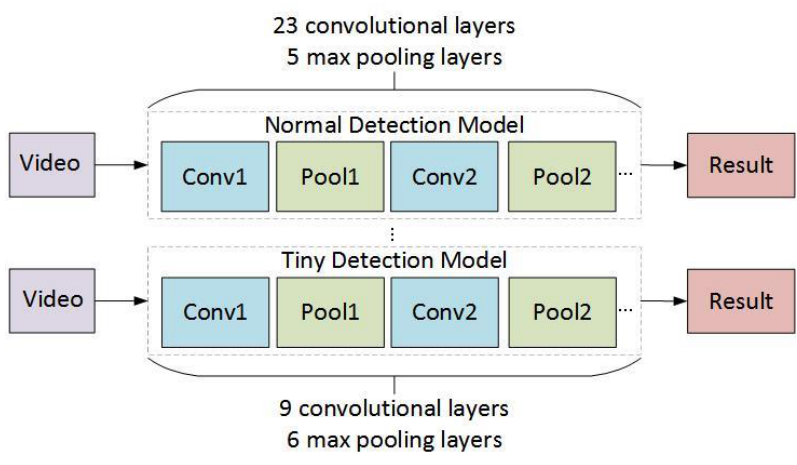
Figure 4. Multi-data pipeline CNN framework.